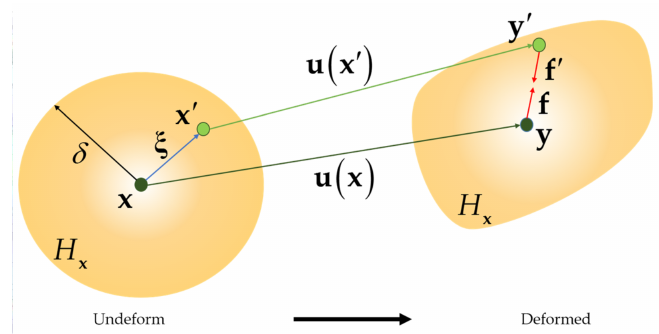
Figure 1. Illustration of PD forces